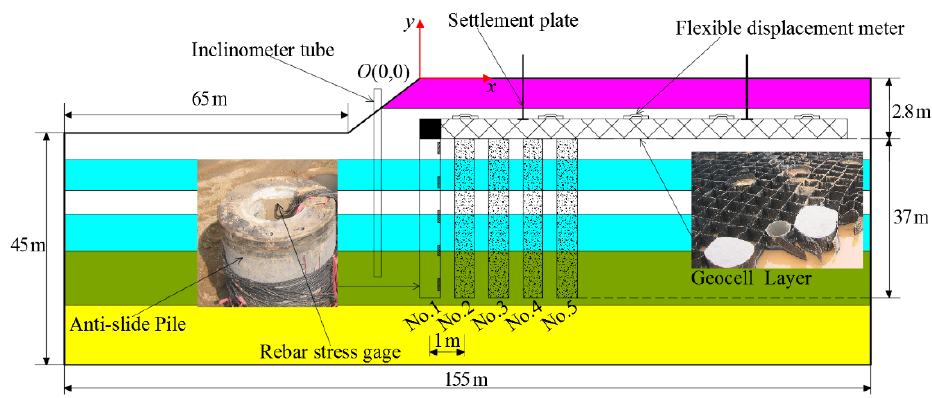
Figure 6. A schematic diagram showing the sectional details of monitoring of the riverbank slope model in this study; point O is the origin of values of model calculation and actual measurement (155 m wide, 65 m from the riverbank slope toe to the left boundary of the riverbank slope, and 90 m from the riverbank slope toe to the right boundary of the riverbank slope).